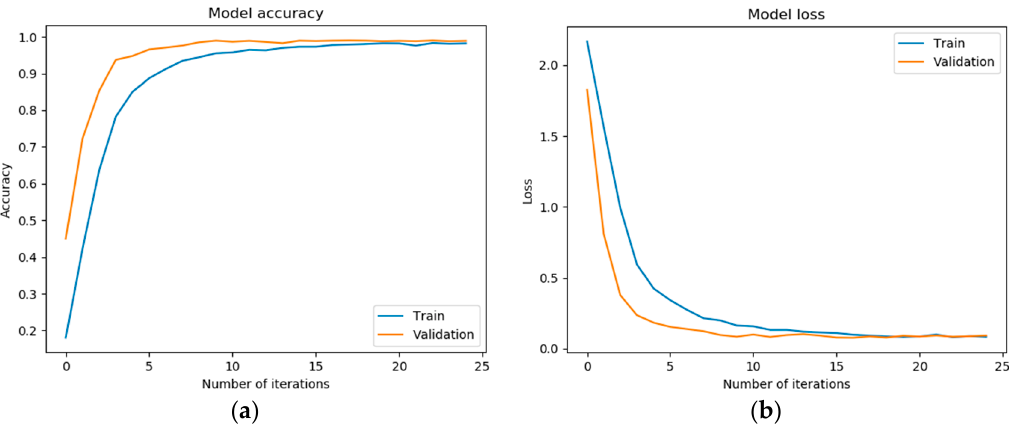
Figure A1. Model accuracy and loss for LSTM network: ( a ) accuracy over 100 iterations. ( b ) loss over 100 iterations.